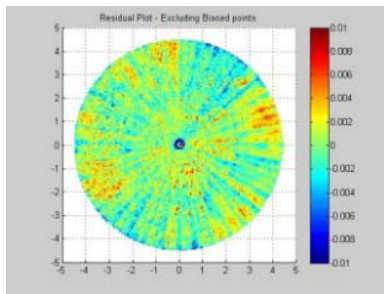
Figure 8: Residual plot of the dish after classified biased points have been removed, with a RMS of 0.0024m.